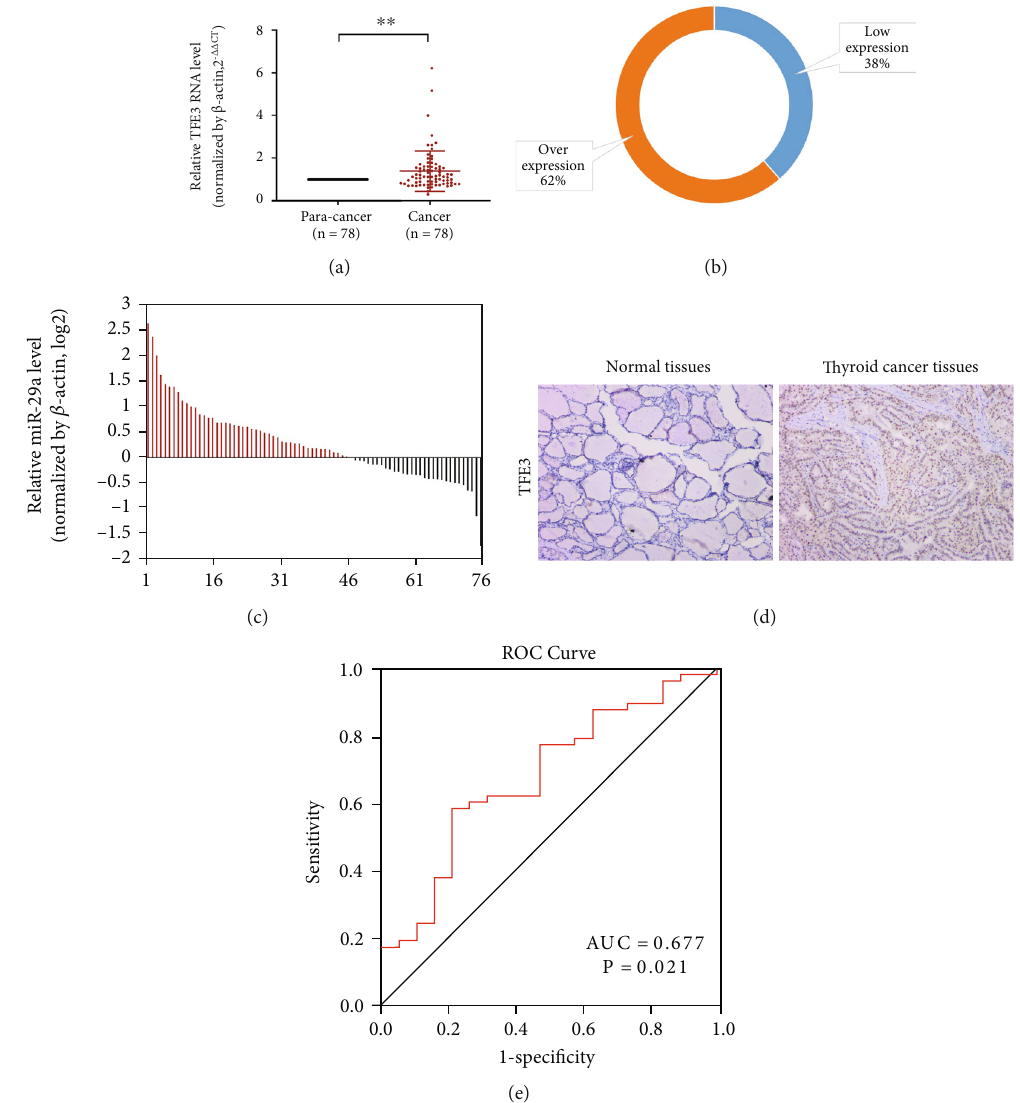
Figure 2: TFE3 was overexpressed and closely associated with lymph node metastasis in PTC. (a – c) TFE3 mRNA expression was signi fi cantly higher in PTC than in normal thyroid tissues. (d) Immunohistochemistry assays showed an increase in TFE3 gene expression in PTC tissues compared with normal tissues ( ∗∗ P < 0 : 01 ). (e) The ROC curve of TFE3 for lymph node metastasis in